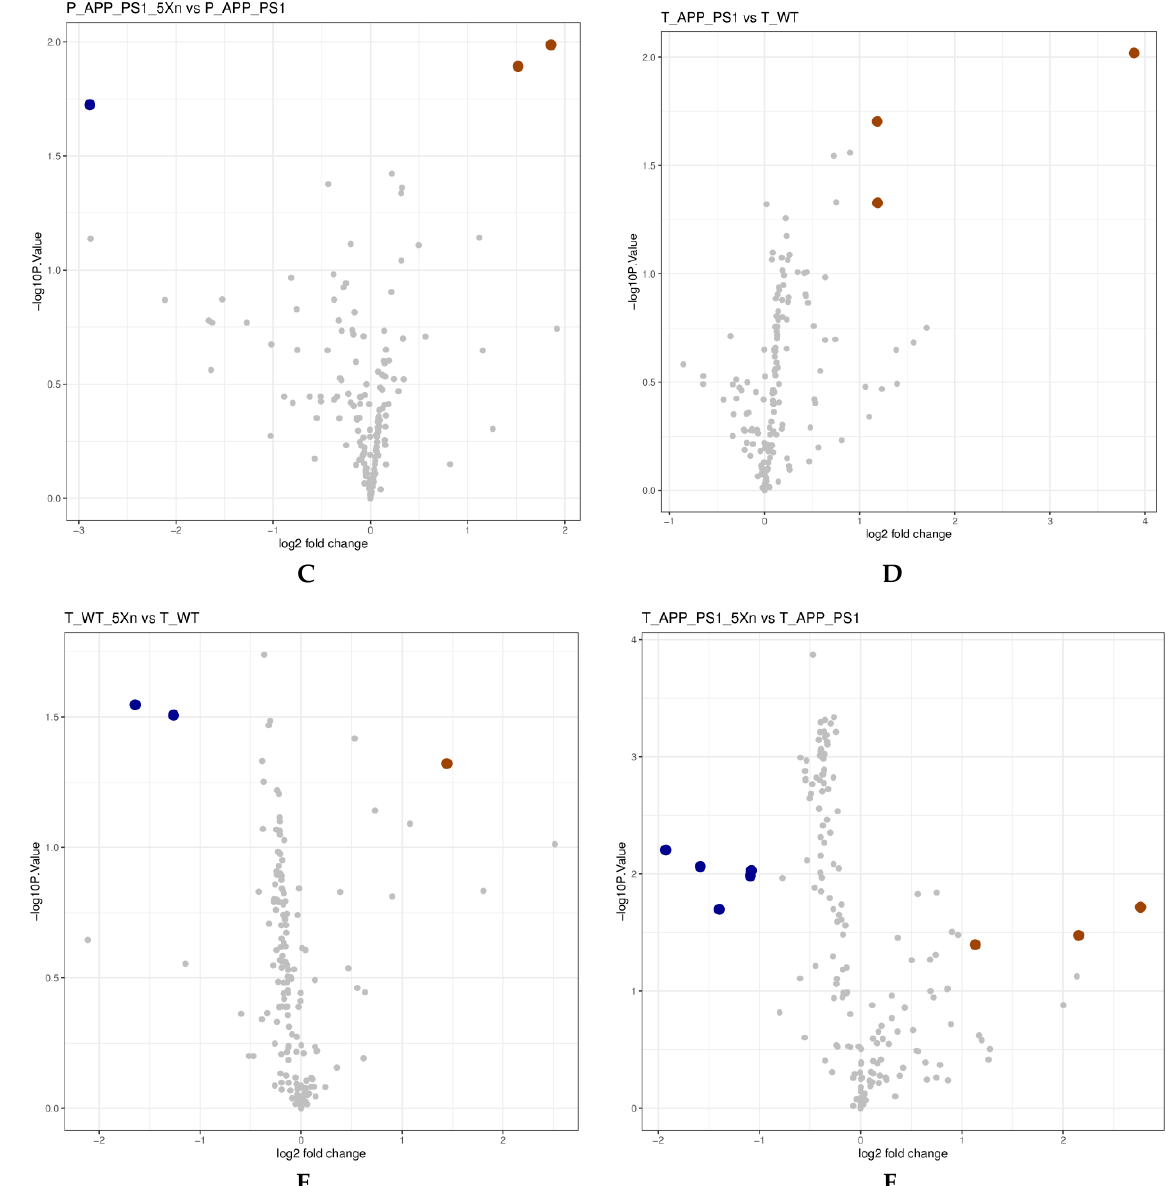
Figure 5. KEGG pathway volcano to predict differences in metabolic pathways of microbial communities. ( A – C ) KEGG pathway volcano in the prevention experiment. ( D – F ) KEGG pathway volcano in the therapy experiment. The X-axis represents log2 fold change, the Y-axis represents − log10 ( p value). Here, the log2 fold change with difference multiple greater than 2 and p value less than 0.05 were the screening conditions. Each of these big blue dots represents a down-regulated metabolic pathway while the big purple dots represent the up-regulated metabolic pathways. Table 1. Differential KEGG pathways predicted via PICRUSt software in the Xn prevention experi- ment.